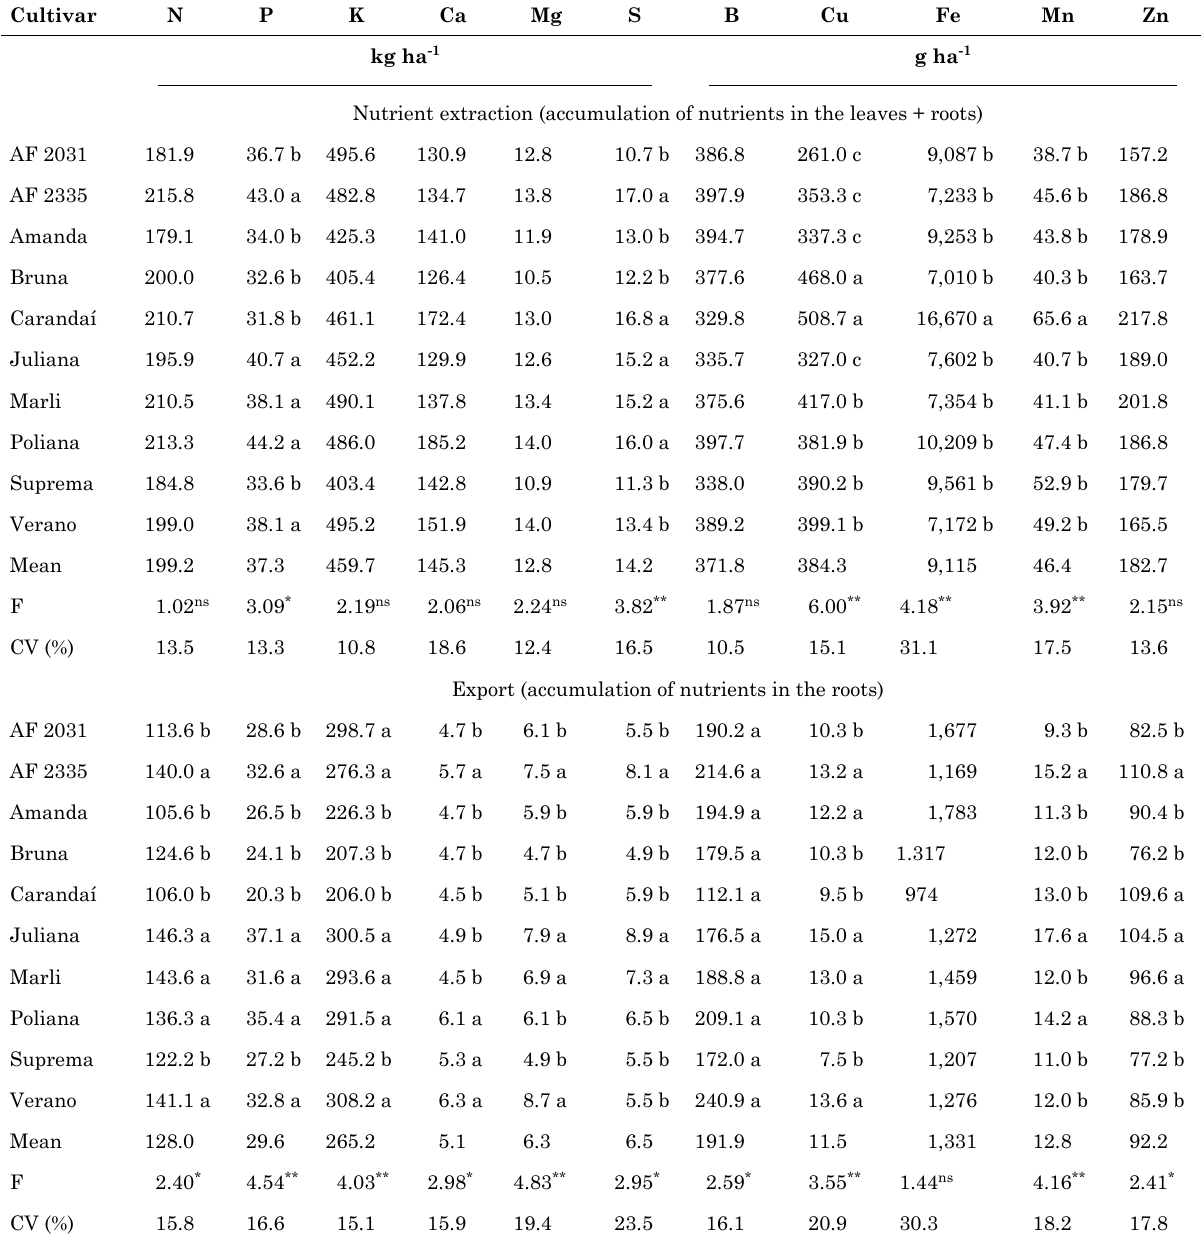
Table 4. Nutrient extraction and export by summer carrot cultivars sown in the summer crop season (Experiment 1)